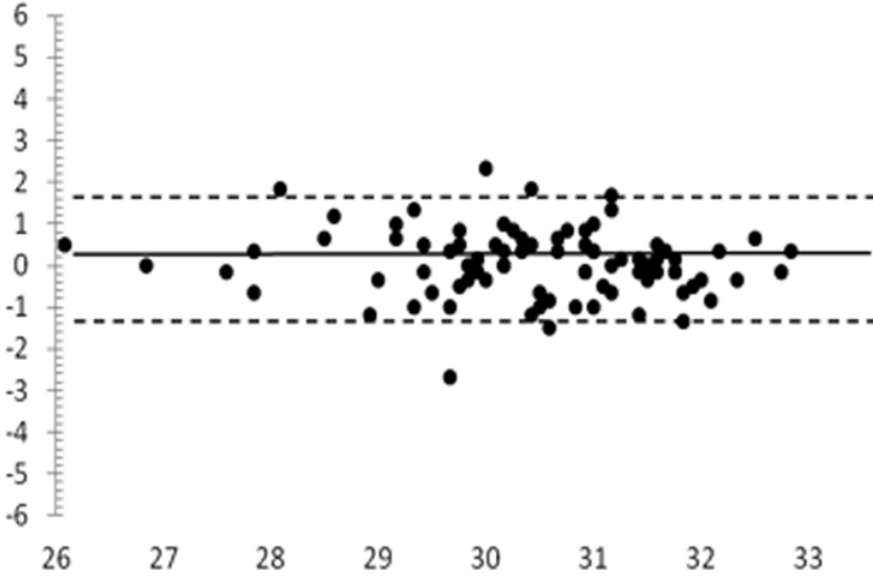
Fig 6. Bland-Altman plots for mean sensitivity of the central 10° (2° – 1° measurement), normal group. x, average of mean sensitivity of the two tests (dB). y, difference of mean sensitivity of the two tests